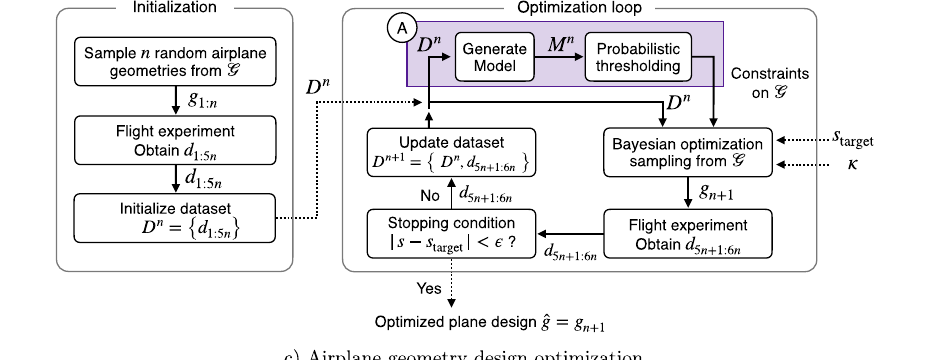
Figure 6. Schematic of the proposed method for ( a ) generating the GMMs for each behavioral type; ( b ) forward and reverse design problem in mapping between airplane geometry and behavior; ( c ) GMM-assisted and unassisted Bayesian optimization of airplane